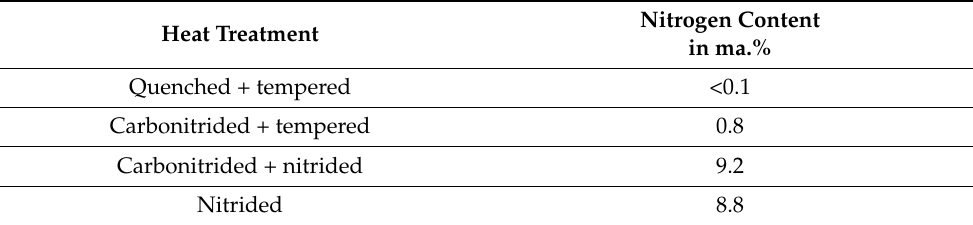
Table 3. Nitrogen content of the specimens for the thermal fatigue investigations in the depth of 1 µ